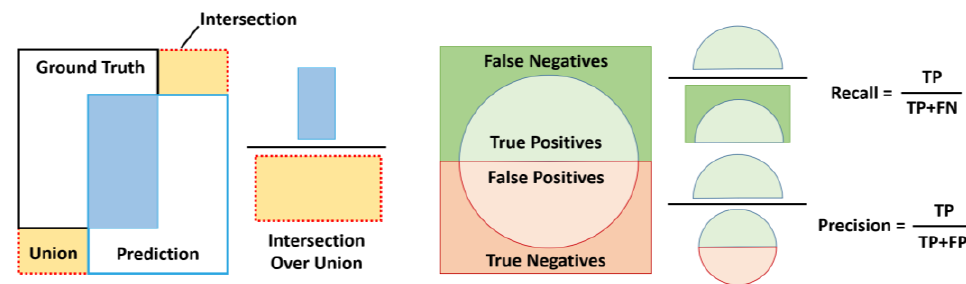
Figure 7. Illustrations of intersection over union (IoU), precision and recall.